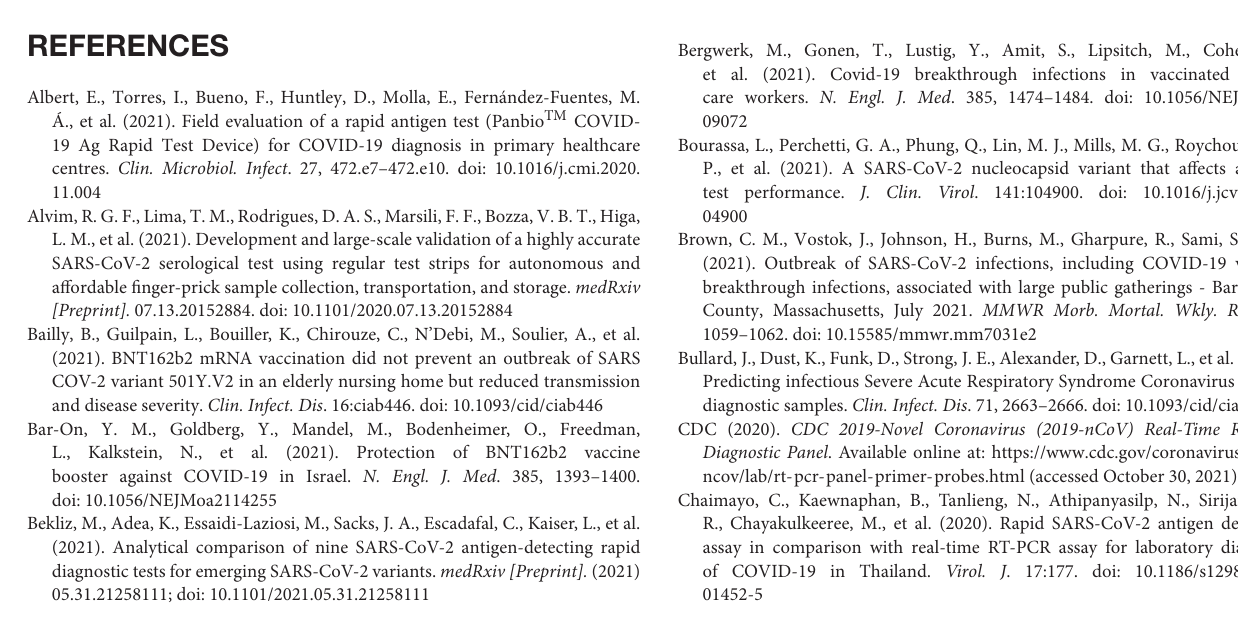
Supplementary Table 7 | Virus titers and genomic RNA (gRNA) copy